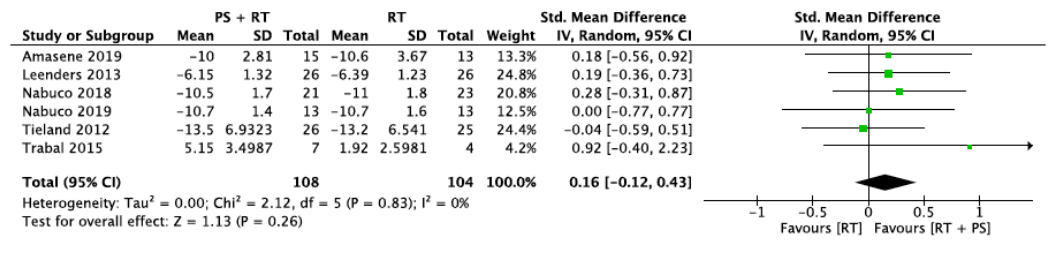
Figure 9. Impact of RT + PS on the five-chair-rise test (5CRT).